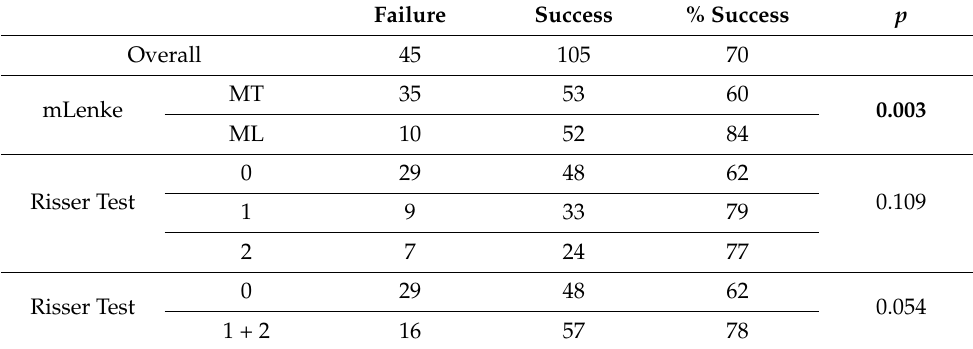
Table 2. Efficiency of brace treatment—overall and subgroups. Bold indicates p < 0.05 .